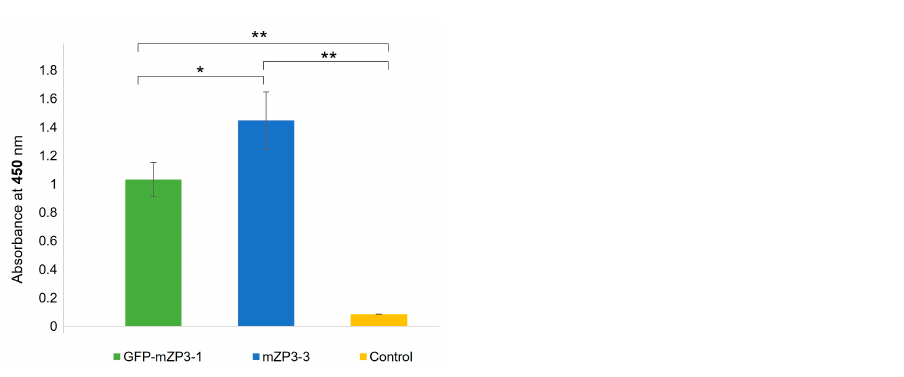
Figure 7. Comparison of serum antibody responses in mice immunized with GFP-mZP3-1, mZP3-3, or PBS after the final boost injection. Absorbance values are shown for sera of each immunized group at a 1:1000 dilution. Data are presented as the mean ± SD absorbance values at 450 nm. * p < 0.05; ** p < 0.001. 3.5. Fertility and Ovarian Effects in BALB/c Mice Immunized with mZP3 Antigens To assess the fertility of female mice immunized with GFP-ZP3-1 or mZP3-3 antigens or PBS, individuals were mated with BALB/c males of similar age three weeks after the final immunization. Female mice were allowed to produce litters. The results showed that there was no significant reduction in the fertility or litter size of mice immunized with plant-produced GFP-ZP3-1 or mZP3-3 antigens. All animals in the treated groups and control group were fertile. No significant reduction in the mean litter size of mice immun- ized with recombinant GFP-mZP3-1 was achieved (Table 2). Although one animal from